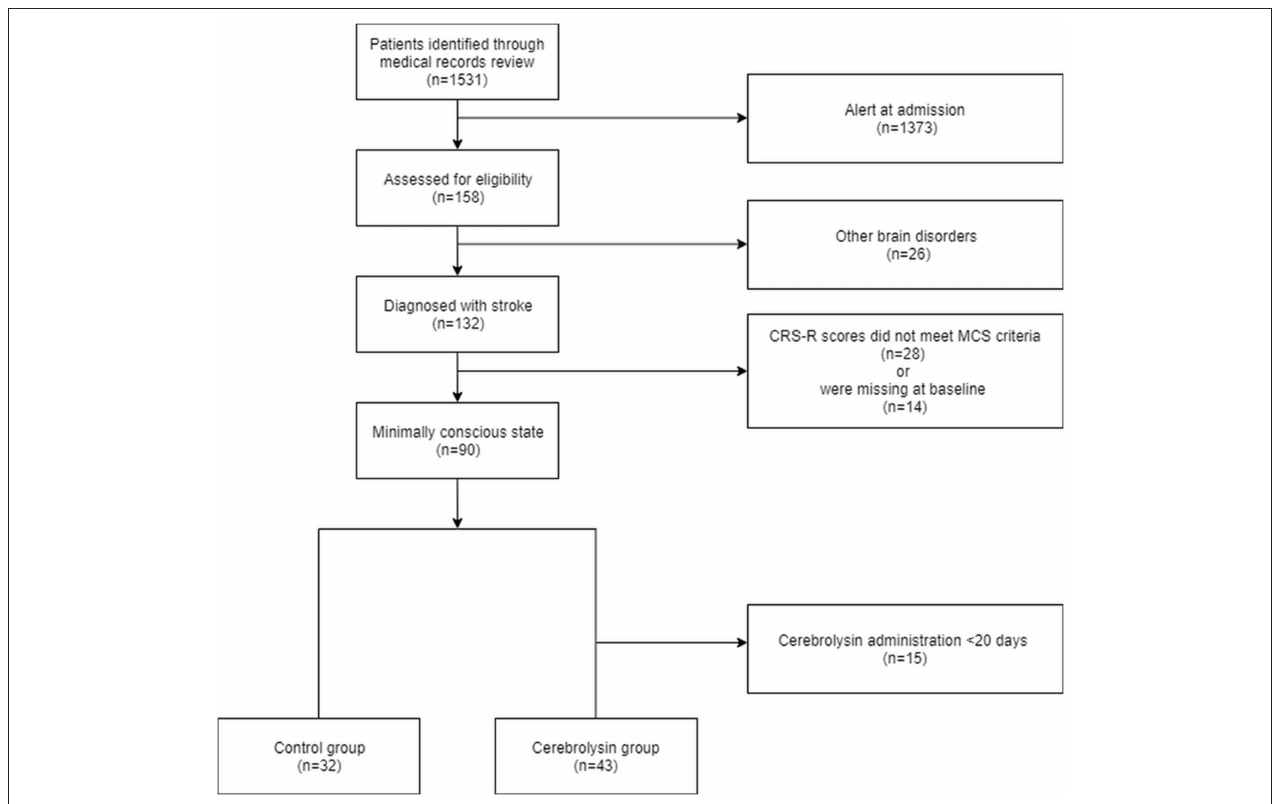
FIGURE 1 | Flow chart of inclusion and disposition of subjects.